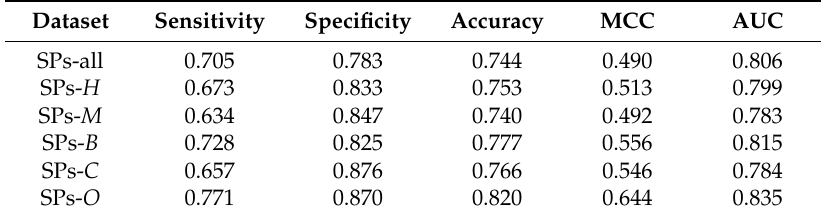
Table 3. The performance of the optimum feature subset general Mammalia secreted proteins and five species-specific secreted proteins over five-fold